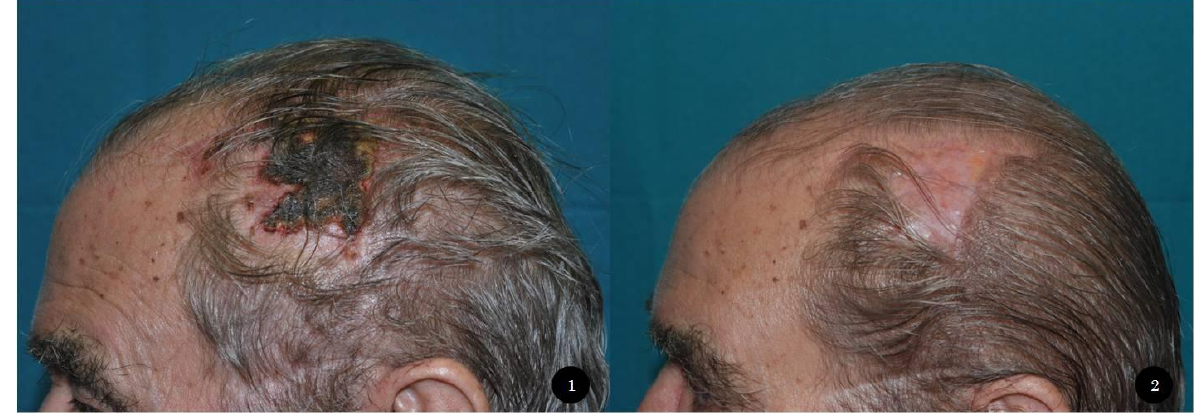
FIGURE 1. (1) Temporoparietal necrotic ulceration at presentation. (2) Alopecic area after 3 months of corticosteroid